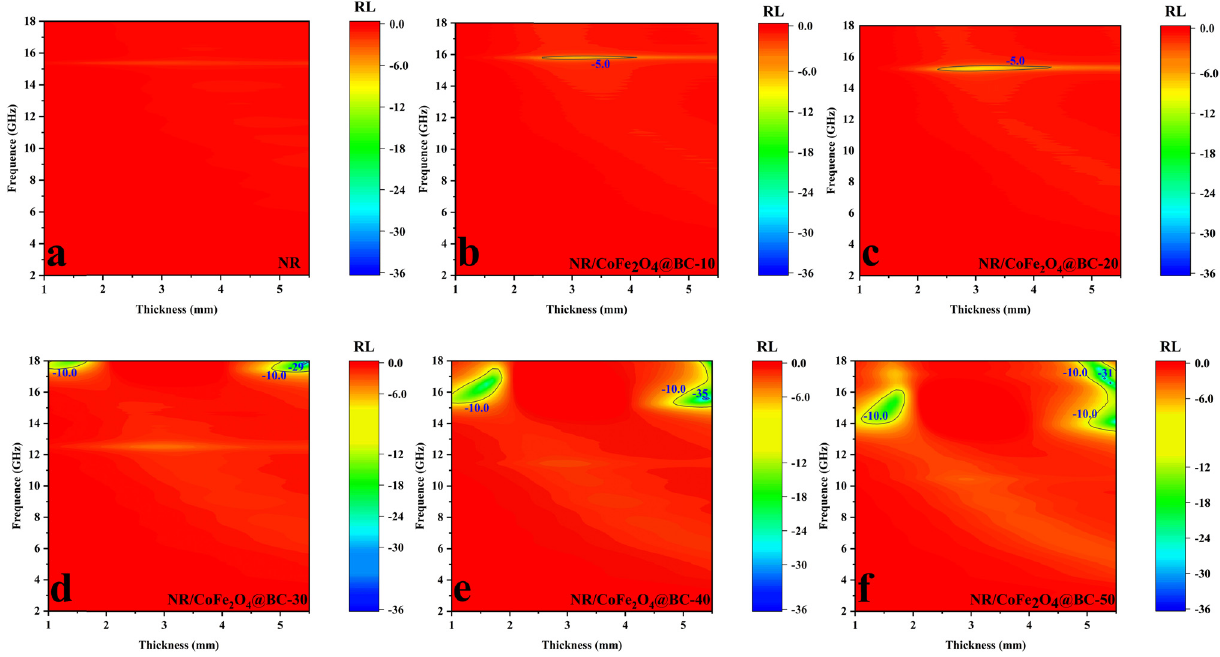
Figure 8: Contour plots of frequency - and thickness - depended RL NR composites with di ff erent CoFe 2 O 4 @BC